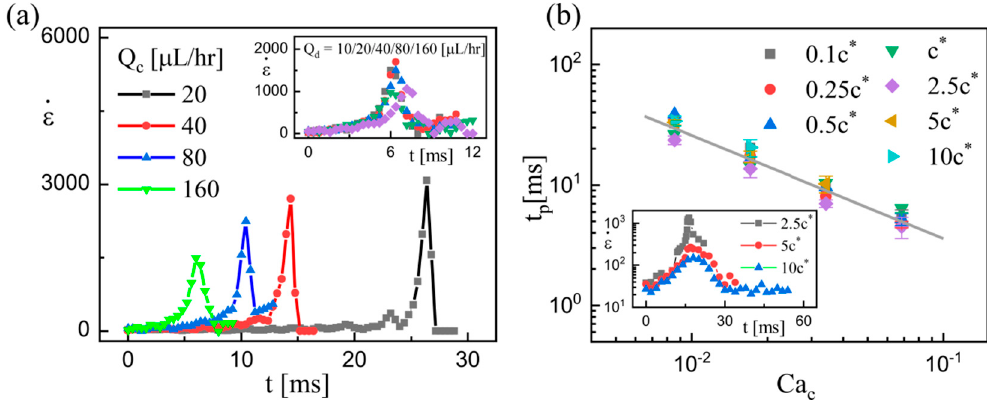
Figure 5. ( a ) Extensional strain rate (cid:2013)(cid:4662) as functions of the elapsed time at different Q c . The moment when the maximum ε (cid:4662) occurs is regarded as the transition time t p . The PEO concentration c = c* . Inset: The time-varied (cid:2013)(cid:4662) at different Q d . ( b ) Values of transition time t p as functions of capillary number Ca c . The straight line t p ~ Ca c-0.86 is the best fit, and the error bars represent standard deviations. Inset: The time-varied (cid:2013)(cid:4662) at different c .